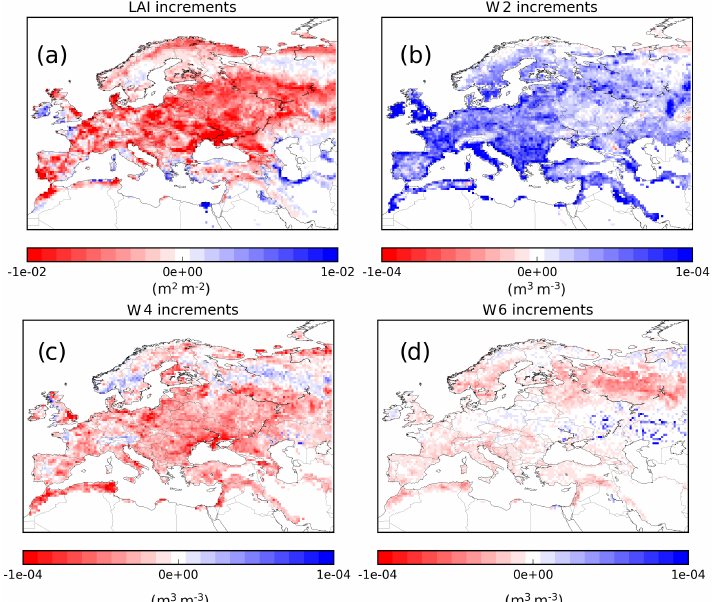
Figure 6. Averaged analysis increments for the whole period 2000–2012. Four control variables are illustrated: (a) leaf area index and soil moisture in (a) the second ( w 2 , 1–4cm), (b) fourth ( w 4 , 10–20cm) and (c) sixth ( w 6 , 40–60cm) layer of